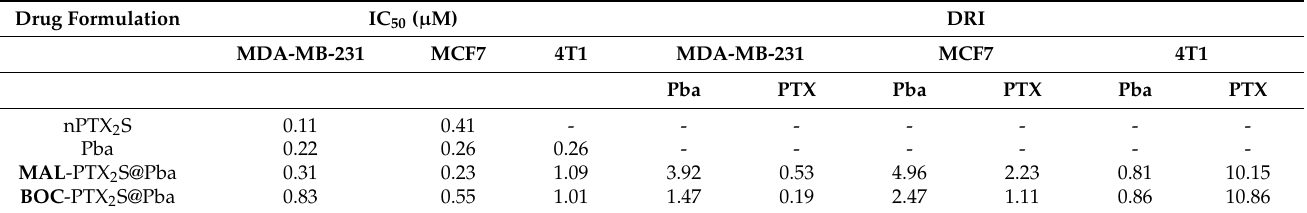
Table 1. IC 50 and Dose-Reduction Index (DRI) values calculated by the Compusyn software from the photo-toxicity data (Figure 5d–f) of cells exposed to the different drug formulations/combinations. The DRI values were calculated for cells exposed to combination therapy and indicate how many folds the concentration of each single drug can be reduced to obtain a survival value (Fa, Fraction affected) of 50%.